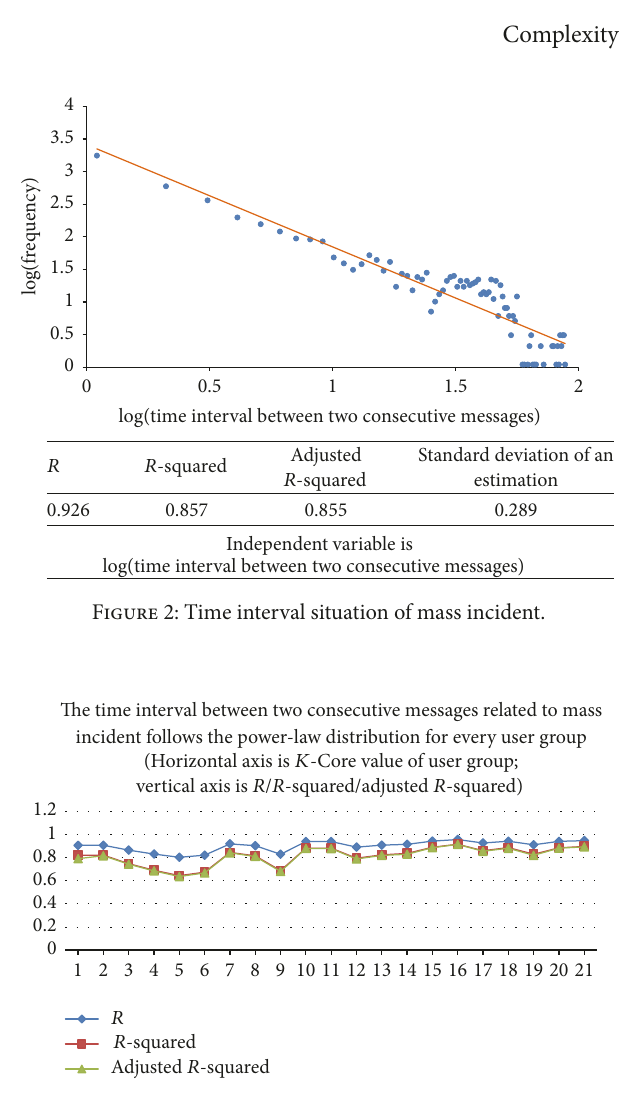
Figure 3: Time interval of mass incident and 𝐾 -Core decomposi- tion (Sig. = .000). (In Jiangsu Qi dong OJI PAPER incident, 21 user groups are defined according to 𝐾 -Core value. It shows that the time interval of messages sending is following power-law distribution inside every group.)